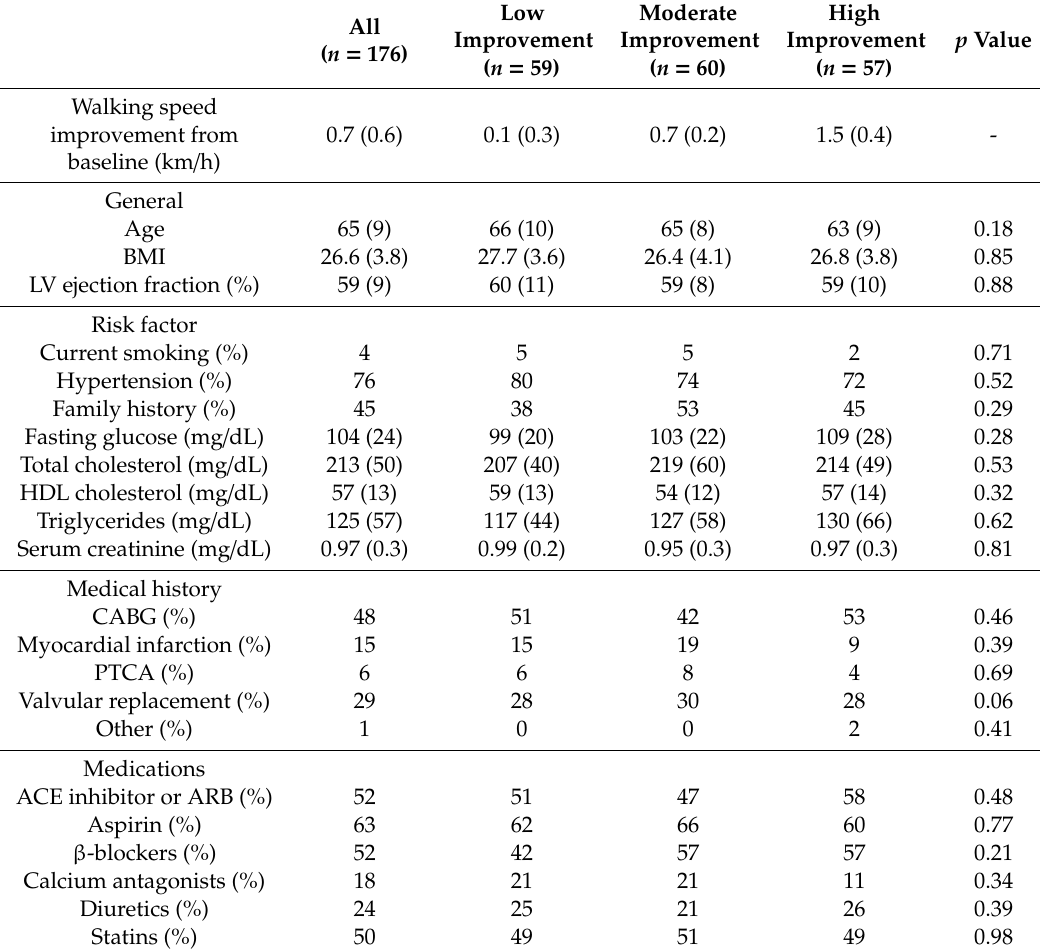
Table 2. Clinical characteristics of the subjects 3 years after baseline subdivided by tertiles of improvement of walking